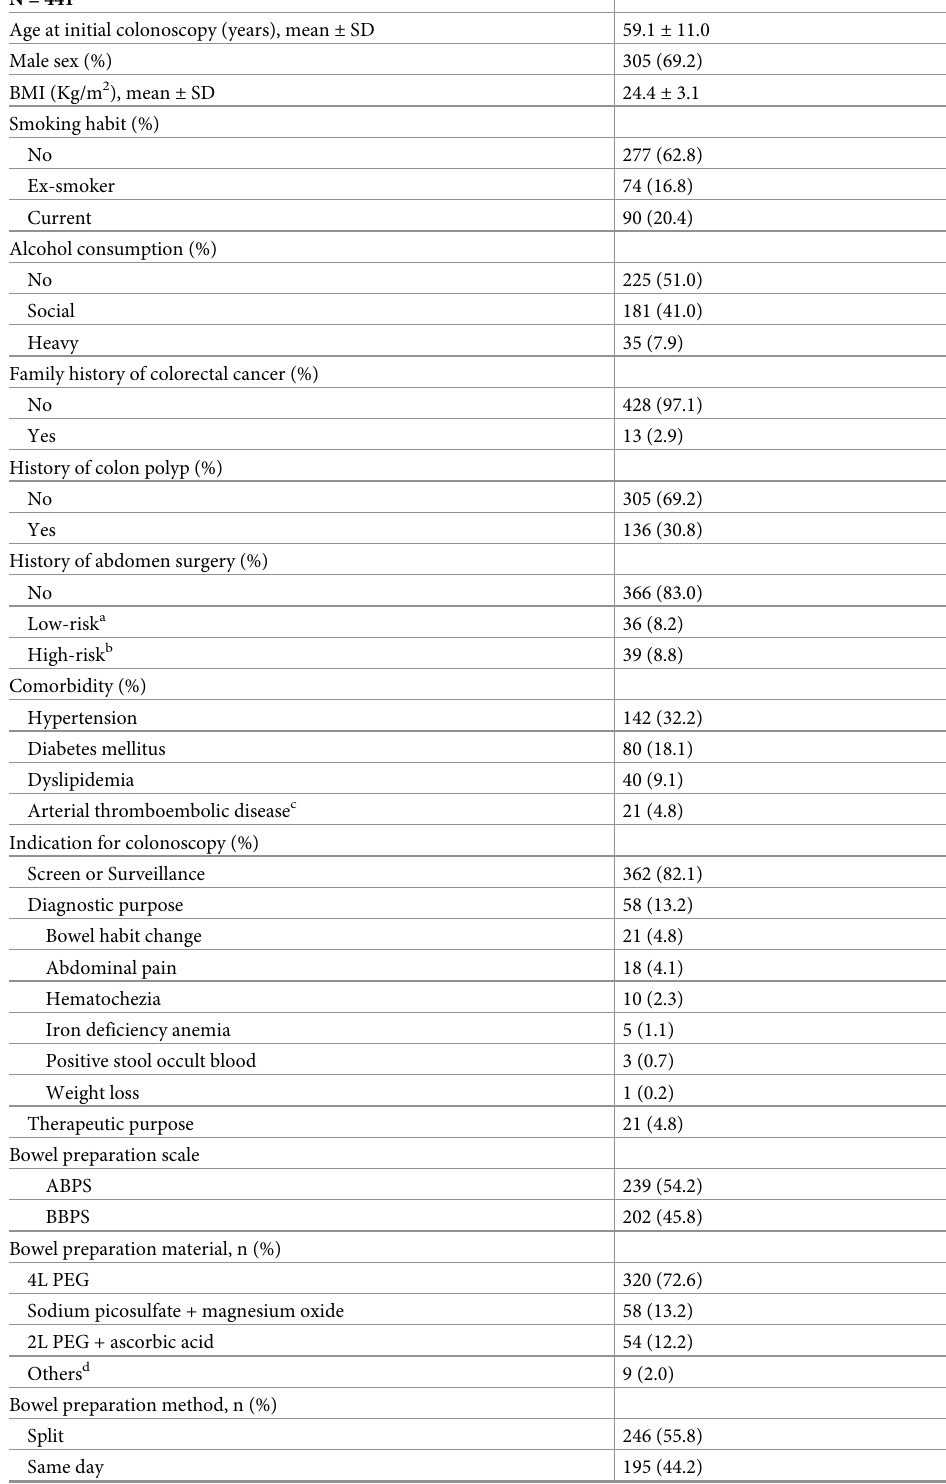
Table 1. Baseline characteristics of the study subjects and initial colonoscopy. N =